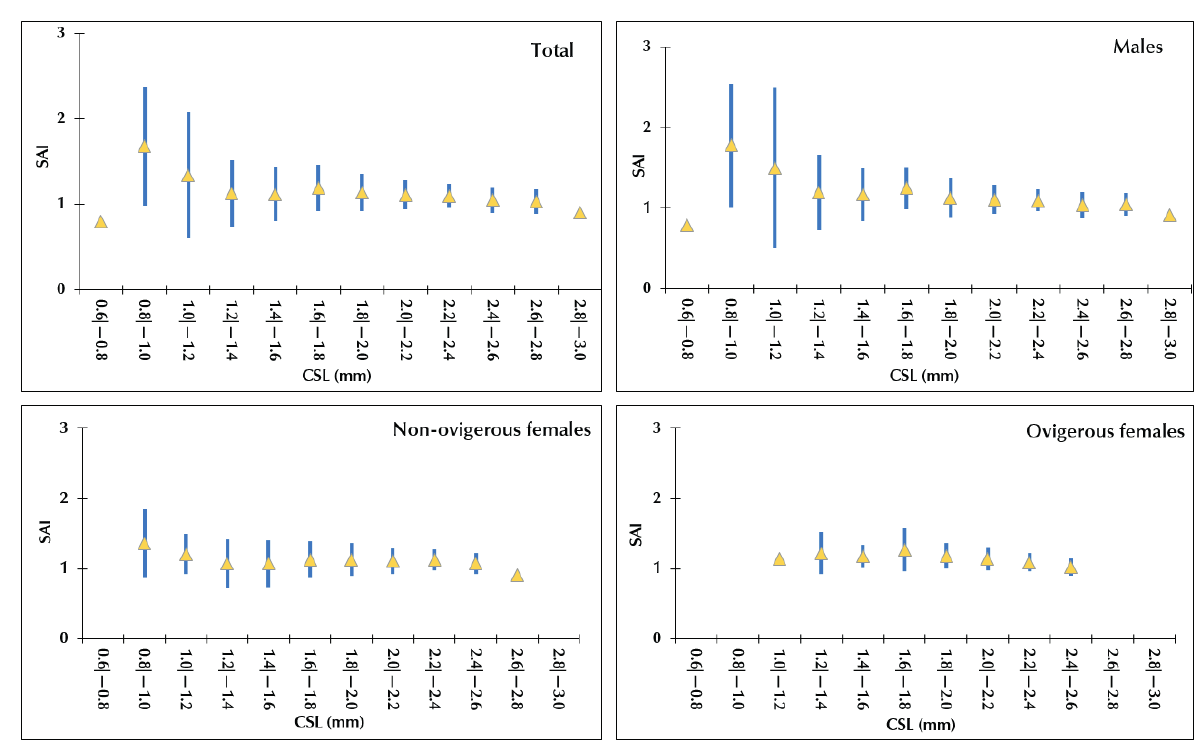
Figure 2. Pagurus criniticornis . Variation of the mean shell adequacy index (SAI) values for total of population, males, non-ovigerous females and ovigerous females. (Data are expressed as mean ± SD)